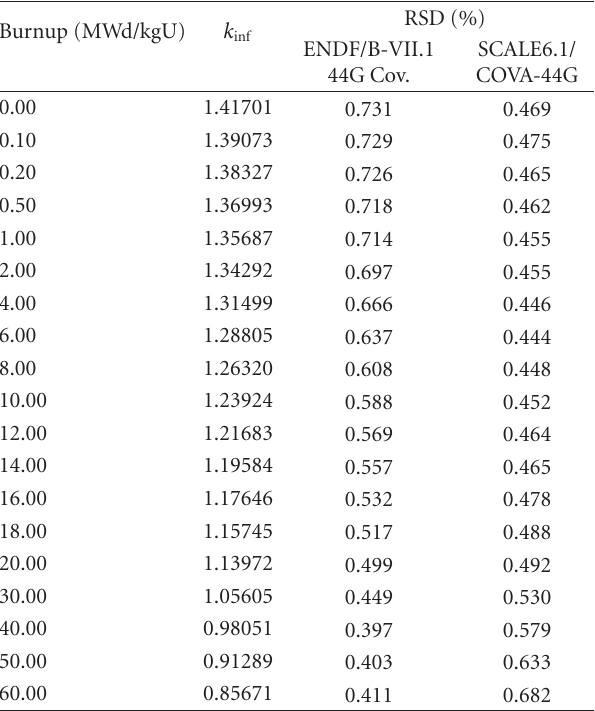
Table 2: k inf ’s and their uncertainties versus pin burnup with ENDF/B-VII.1 and SCALE6.1/COVA covariance